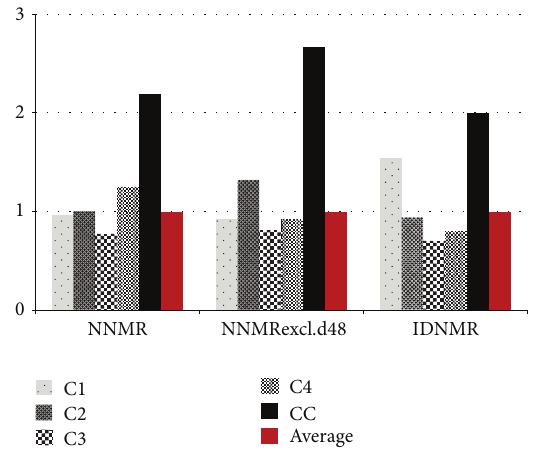
Figure 14: Total number of incubator-dependent-neonates that survived during the two-year period. “Average” was based on the outreach centres